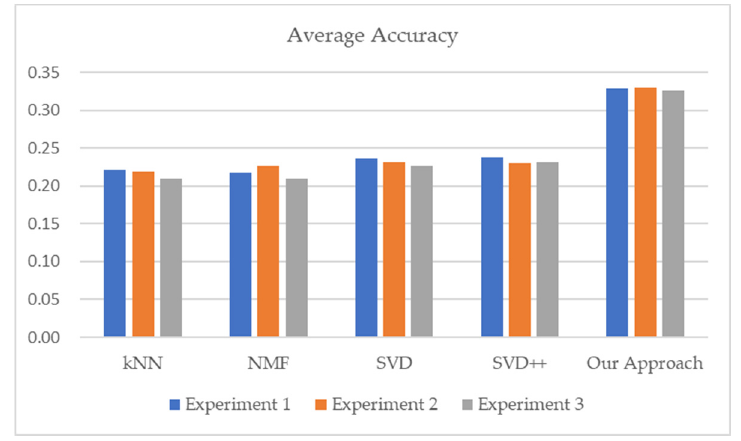
Figure 21. Average accuracy comparison of our proposed approach with the other approaches.